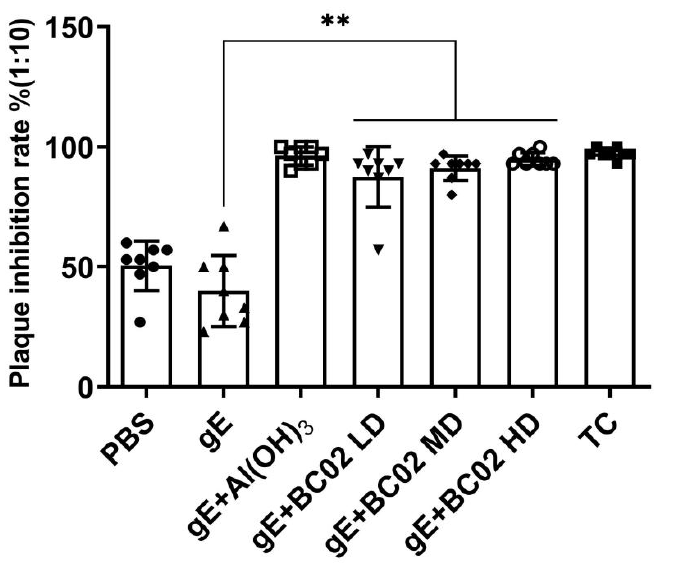
Figure 5. Inhibitory rate of VZV plaque formation by serum antibodies from immunized mice after booster immunization. The immunized mouse serum was diluted at 1:10, and the change of VZV plaque formation inhibition rate in different immunization groups. ** Indicates that there is a significant statistical difference between gE + BC02 LD/MD/HD compared with gE, respectively; p < 0.05. LD: Low dose, MD: Medium dose, HD: High dose.